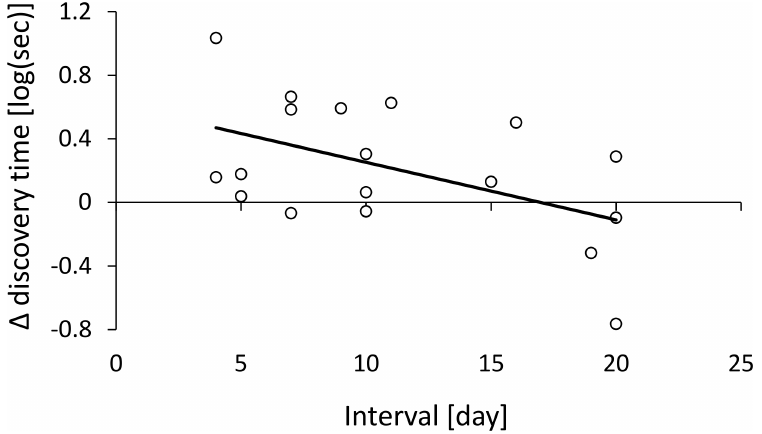
Fig 4. The effect of the time interval (in days, horizontal axis) between tests on the difference between food-discovery time before and after this interval ( Δ discovery time, vertical axis). Values abovezero indicatethat coloniesreachedthe food reward faster after the time intervalthan before it, whilevalues below zero indicatethat coloniesreachedthe food reward faster before the time interval. As intervals become large, food-discovery time returns to the basic initial levels (aroundzero), which takes place accordingto this model after ~16 days.